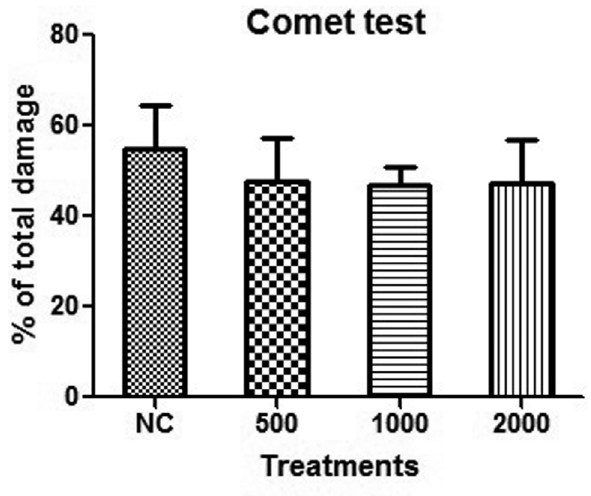
Figure 1 - Comet test. The doses of andiroba oil are in mg/kg/day. NC – negativecontrol.Thecolumnsrepresentthemean (cid:5) SDandwereanalyzed by ANOVA. There were no significant differences between the responses to andiroba oil and the negative control, or among the doses of oil tested.